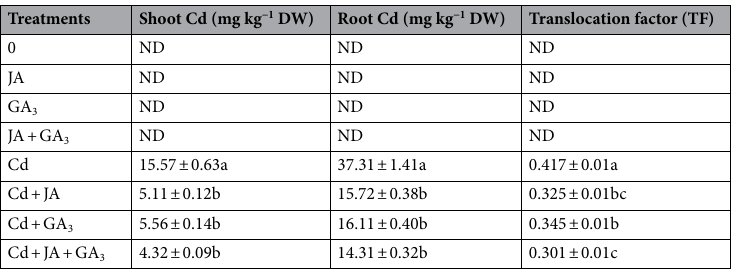
Table 1. Effect of JA and GA 3 applied individually and/or in combination on Cd accumulation in shoot and root, and translocation factor in chickpea under Cd toxicity (Mean ± S.E.).